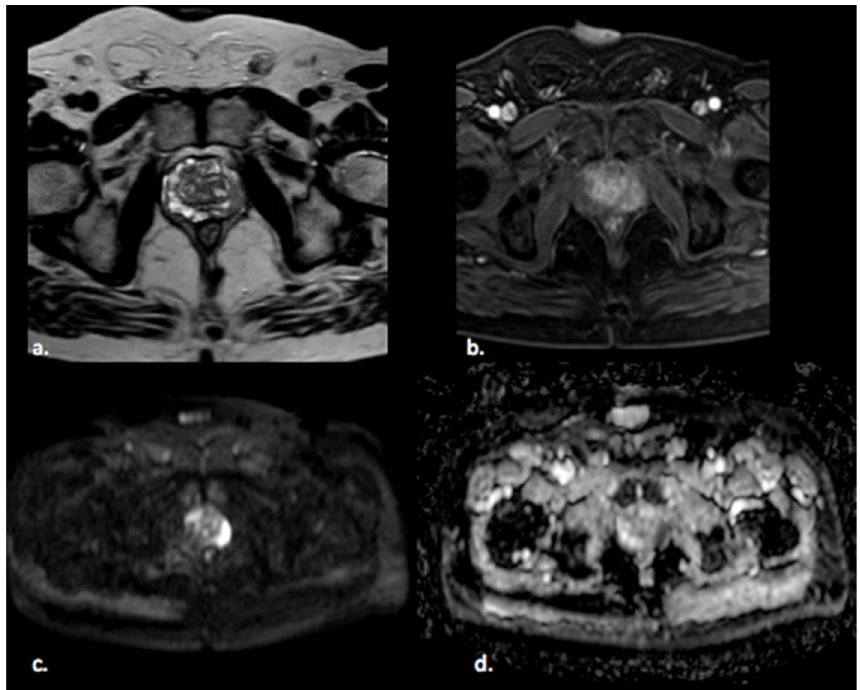
Figure 1. A 65 year old man with a PI-RADS 5 lesion in the left postero-lateral segment of the PZ of midgland, hypointense in T2-weighted images ( a ), with early enhancement in DCE images ( b ), markedly hyperintense on DWI, and hypointense on ADC images ( c , d ).